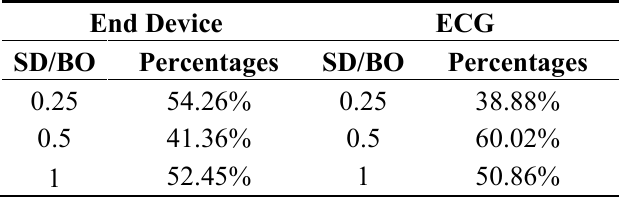
Table 9. Percentage of packets that received ACKs on the first attempt for BO = 9.